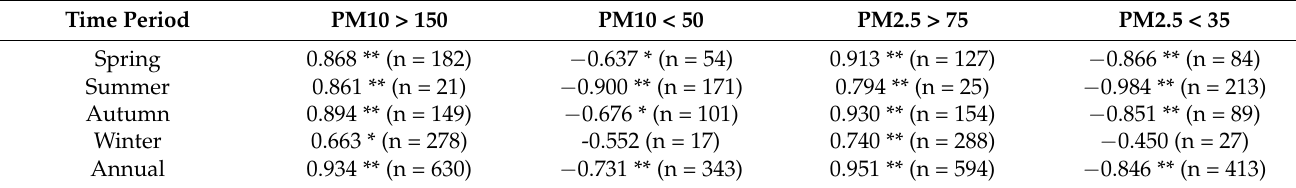
Table 1. Spearman correlation coefficients between concentrations of PM10 and PM2.5 and the days that PM10 > 150 µ g/m 3